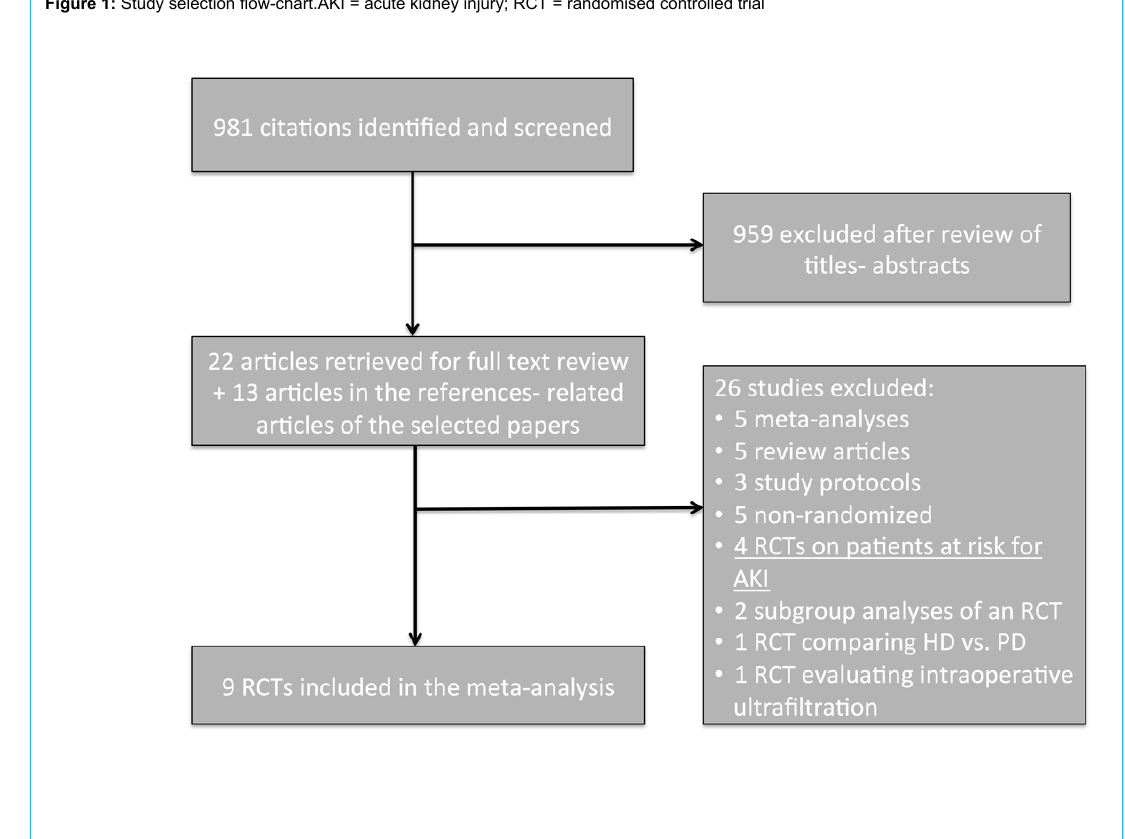
Figure 1: Study selection flow-chart.AKI = acute kidney injury; RCT = randomised controlled